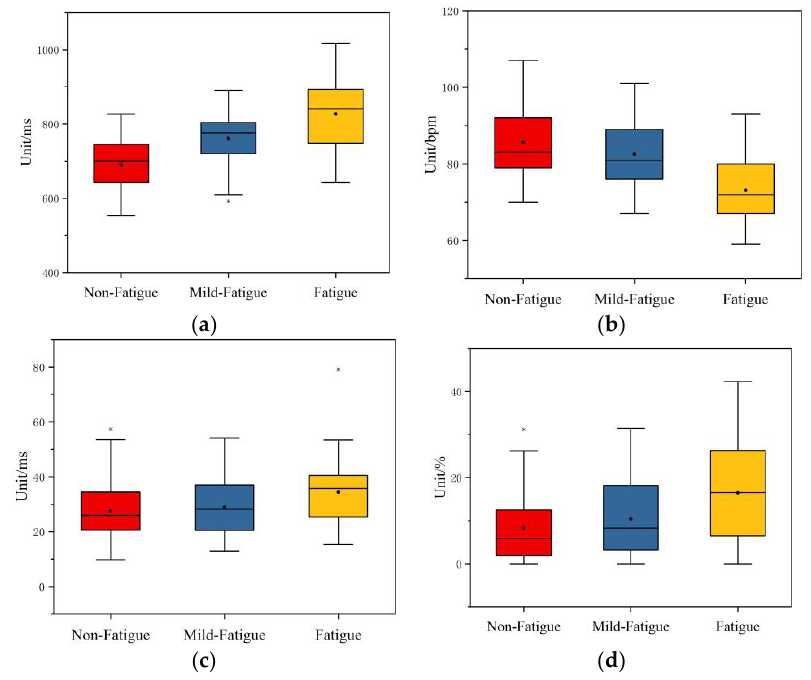
Figure 10. The boxplot of the time domain indexes after feature selection. ( a ) The boxplot of AVNN. ( b ) The boxplot of AVHR. ( c ) The boxplot of RMSSD. ( d ) The boxplot of PNN50.